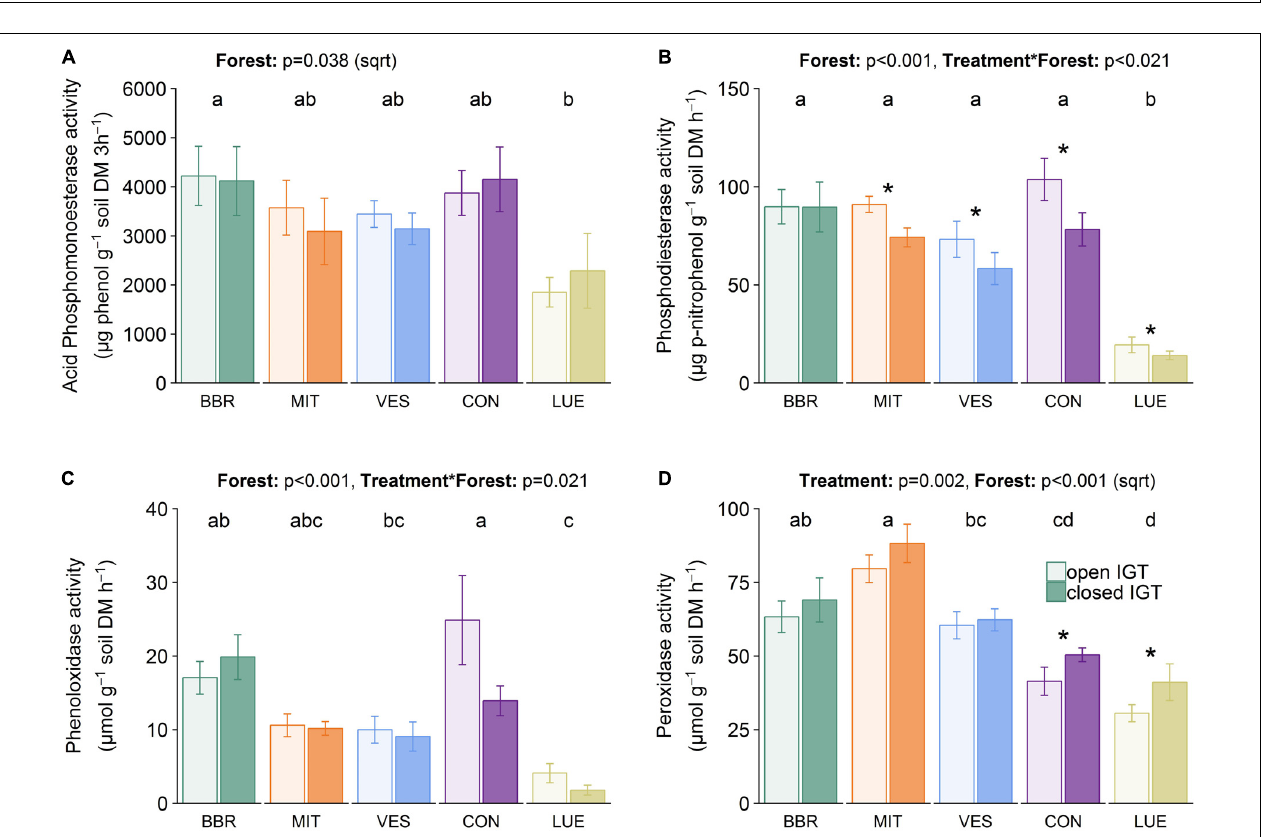
FIGURE 4 | (A) Soluble P and microbially bound P (B) in open and closed IGTs in Bad Brückenau (BBR), Mitterfels (MIT), Vessertal (VES), Conventwald (CON), and Lüss (LUE) after 18 months exposure ( n = 5). Forests sharing no letter are significantly different.